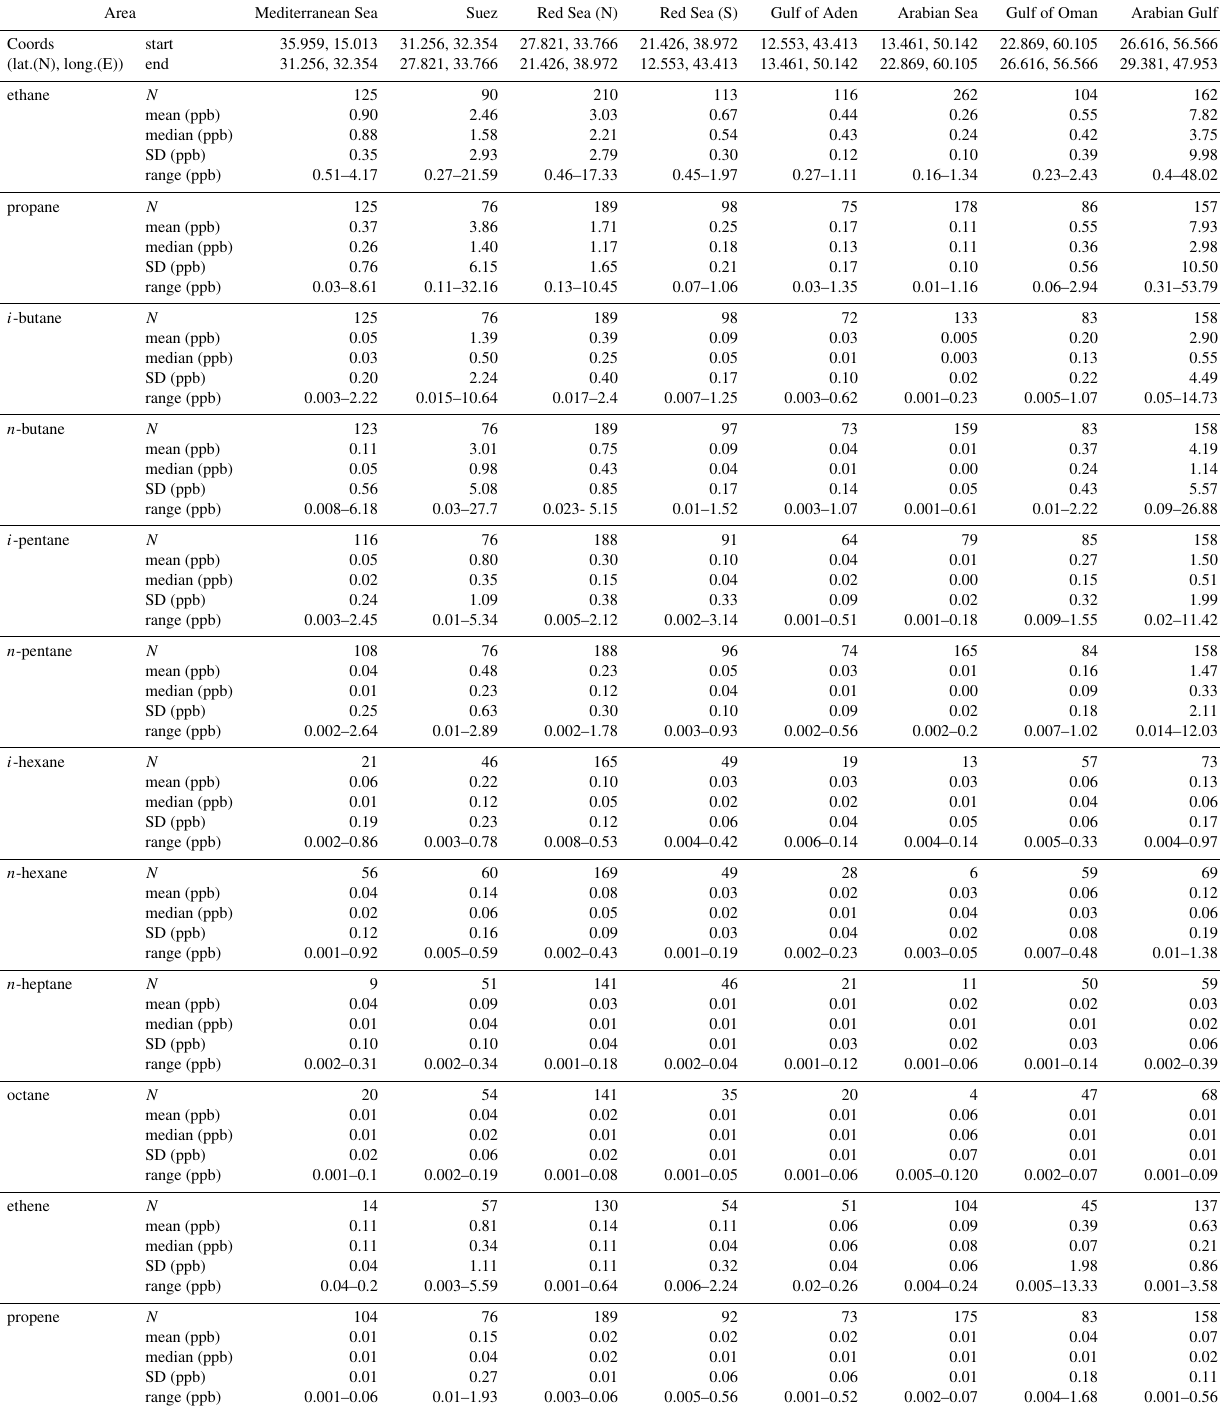
Table 2. Spatial volume mixing ratio means, medians, standard deviations (SDs) and ranges of measured NMHCs. Area Mediterranean